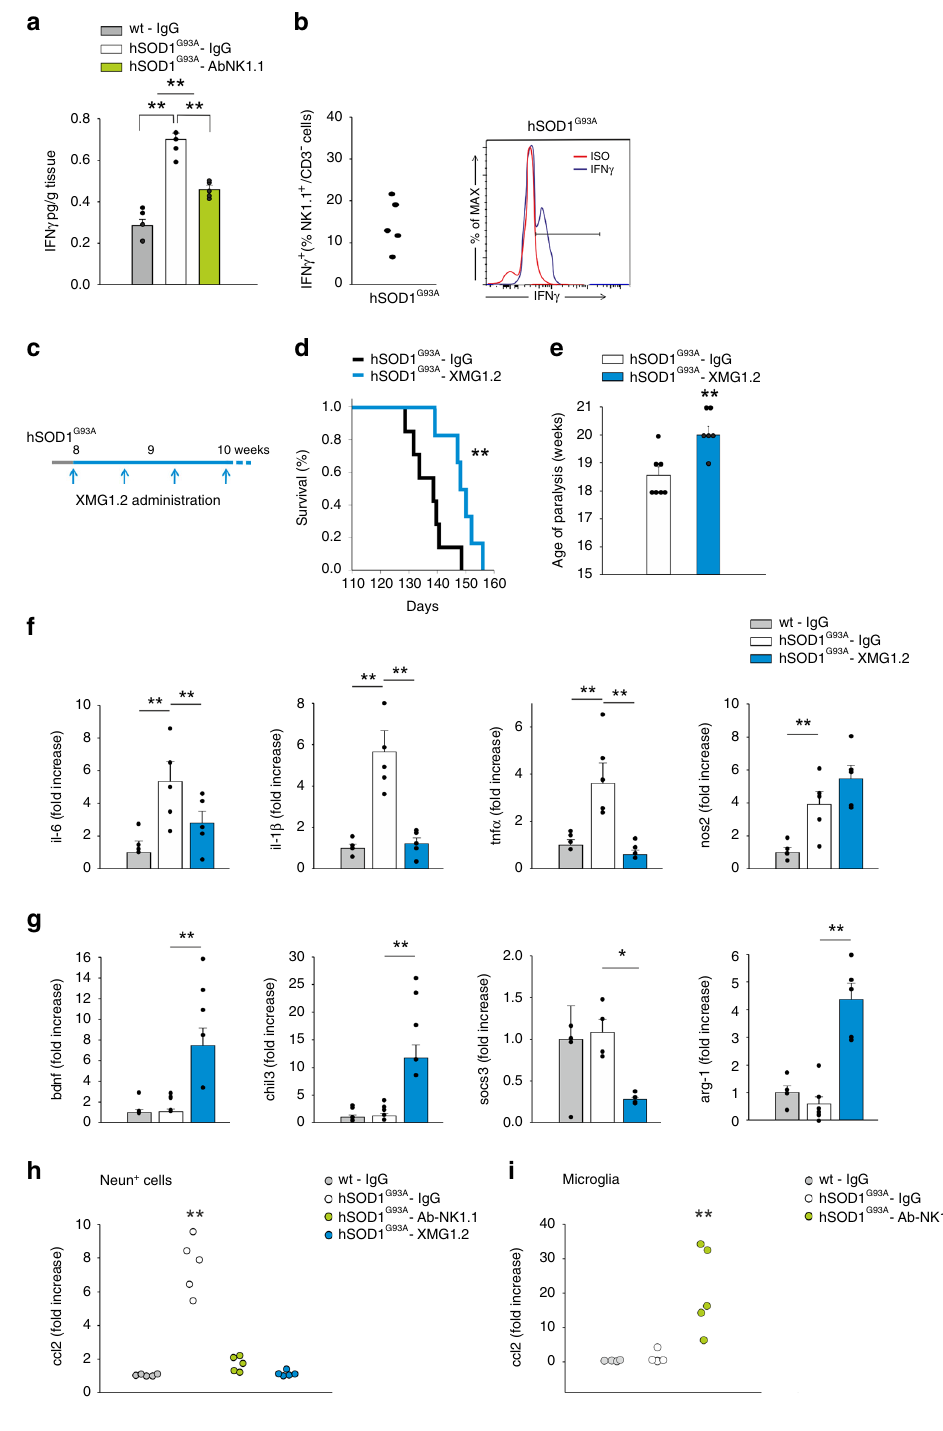
Immunostaining . In different stages of pathology, mice were overdosed with chloral hydrate (400mg/kg, i.p.) and then intra-cardially perfused with PBS and then PFA 4%; brains and spinal cord were then isolated, fi xed in 4% formaldehyde and snap frozen. Cryostat sections (20 μ m) were washed in PBS, blocked (3% goat serum in 0.3% Triton X-100) for 1 h, at RT, and incubated overnight at 4°C with speci fi c antibodies diluted in PBS containing 1% goat serum and 0.1% Triton X-100. The sections were incubated with the following primary Abs: anti-NKp46 (1:50), anti-CD31 (1:200), anti-Smi32 (1:500), anti-ChAT (1:100), anti-Mult-1 (1:100), anti-Foxp3 (1:100) and anti-Iba1 (1:500). For immunostaining on paraf fi n- embedded human motor cortex section, tissues were placed at 60°C for 15 min, incubated in xylene at RT for 25 min, and then transferred sequentially into 100% EtOH, 95% EtOH, 70% EtOH, and 50% EtOH for 4min at RT. The sections